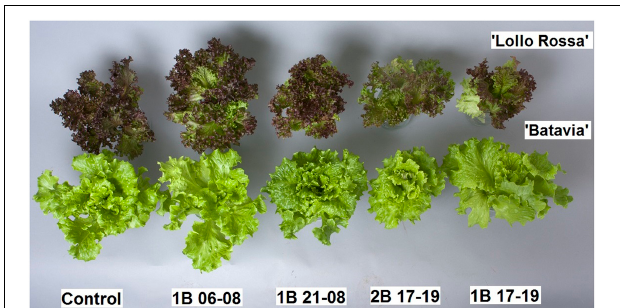
FIGURE 2 | Morphological differences of Lactuca sativa “Batavia” and “Lollo Rossa” grown under the five different LED treatments: Control (no blue addition), Blue light at 45 μ mol m − 2 s − 1 from 06:00 to